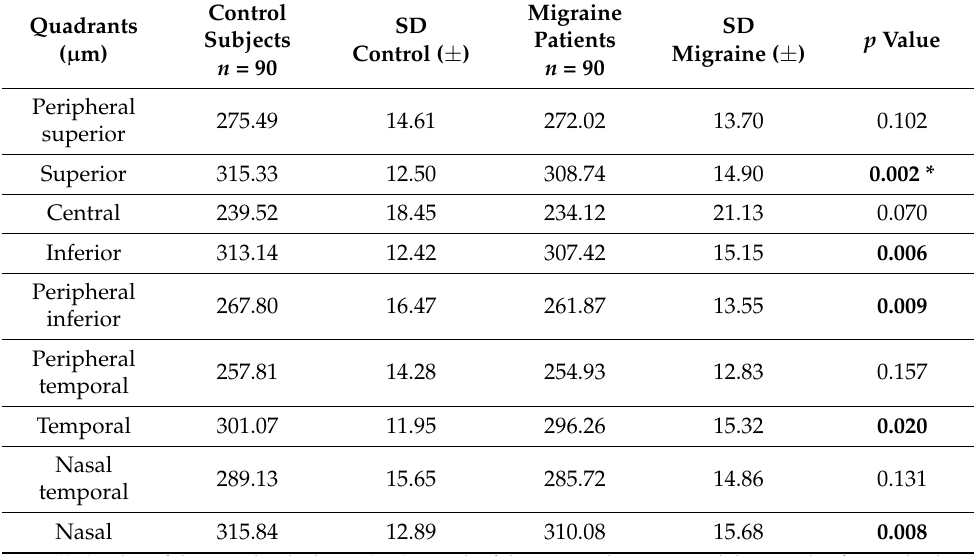
Table 3. Macular thickness ( µ m) in each of the 90 ◦ quadrants around the macula. Quadrants